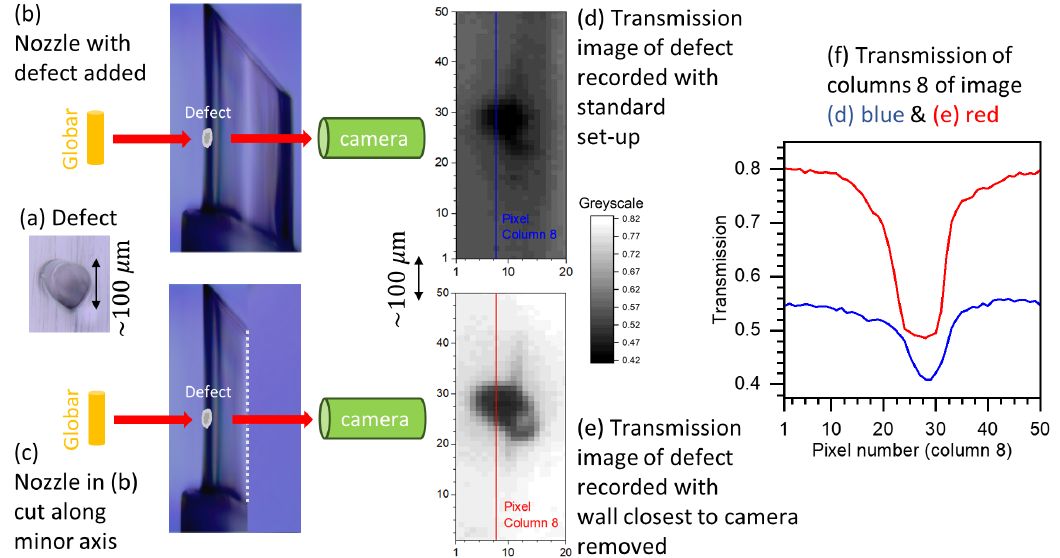
Figure 2. Determining reduction in image quality on surface farthest from camera due to opposite wall; see text for detailed description. Defects as low as ≈ 50 µ m in size are